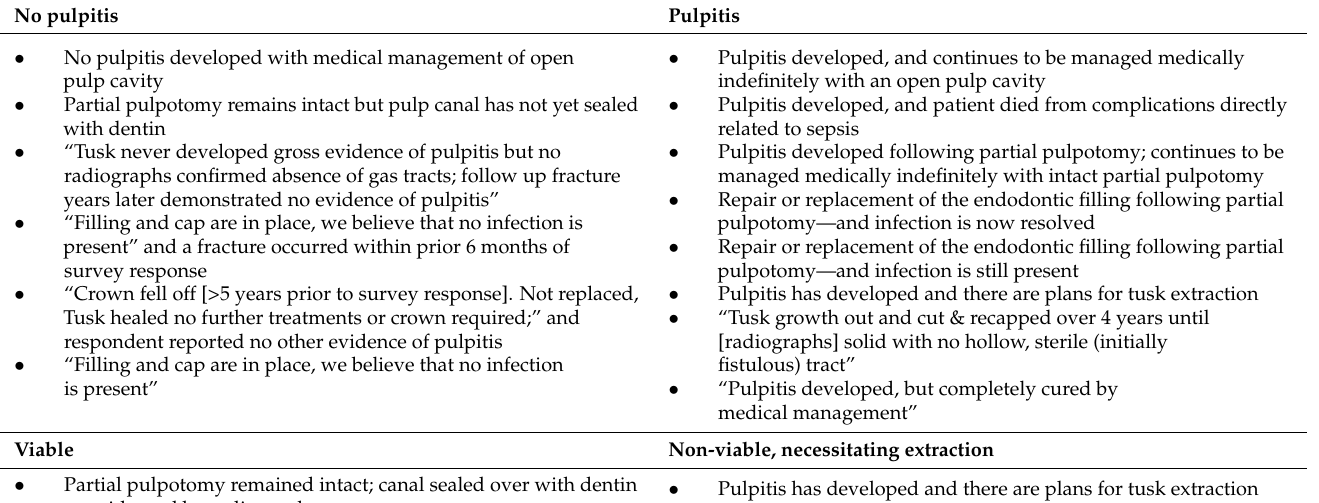
Table 2. How fracture outcomes in the survey were classified for data analysis of objective 5 1